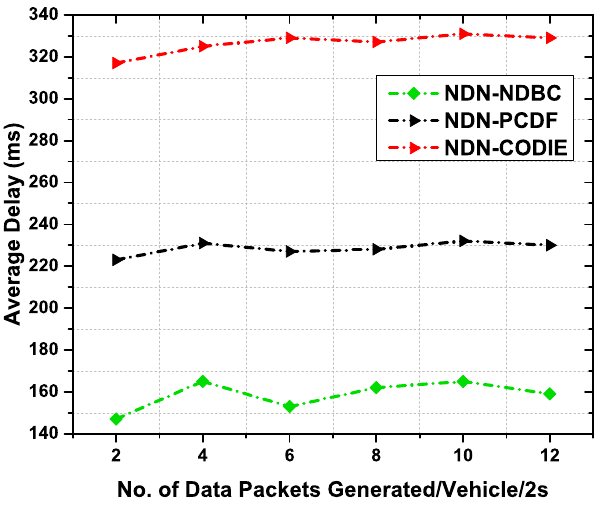
Figure 14. Average Delay as a function of number of data packets generated per 2